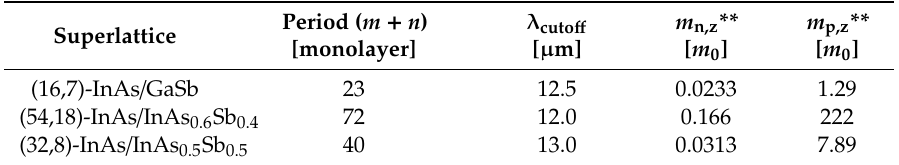
Figure 8. Growth-direction ( a ) electron and ( b ) hole conductivity effective masses for two families of InAs/InAsSb superlattices, and a set of InAs/GaSb superlattices. Table 1. Growth direction electron and hole conductivity effective masses in units of bare electron mass for three superlattices with approximately the same cutoff wavelength.